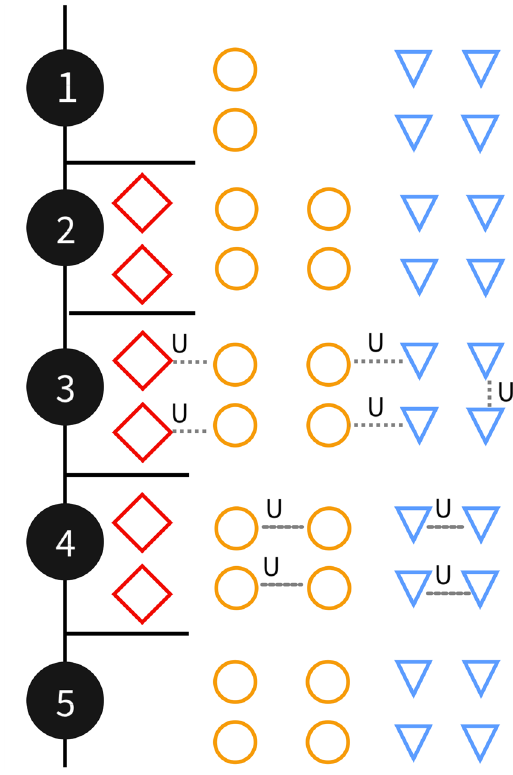
Fig. 1 Generation procedure. Example of one iteration of the generation procedure broken down into fi ve steps. The fi rst line (1) represents the initial system before the iteration. We start with two system qubits (orange circles) and a bath (blue triangles). The fi rst operation (line 1 – 2) is to add two new system qubits and two auxiliary qubit (red diamond). The new qubits are placed to the right of the old ones. The second operation (line 2 – 3) is to act with a unitary U between the indicated qubits and from (3) to (4) we apply another layer of unitaries and, thus, D = 2 for this example. Finally, in line (4) – (5) we discard the auxiliary systems.